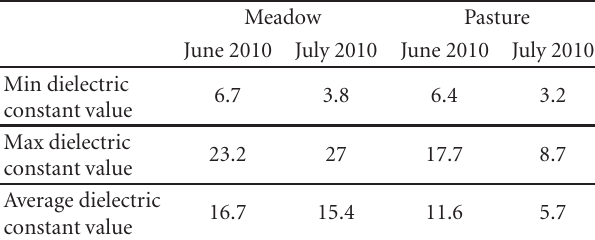
Table 1: Ranges of variability of the dielectric constant (real part) values measured during the field